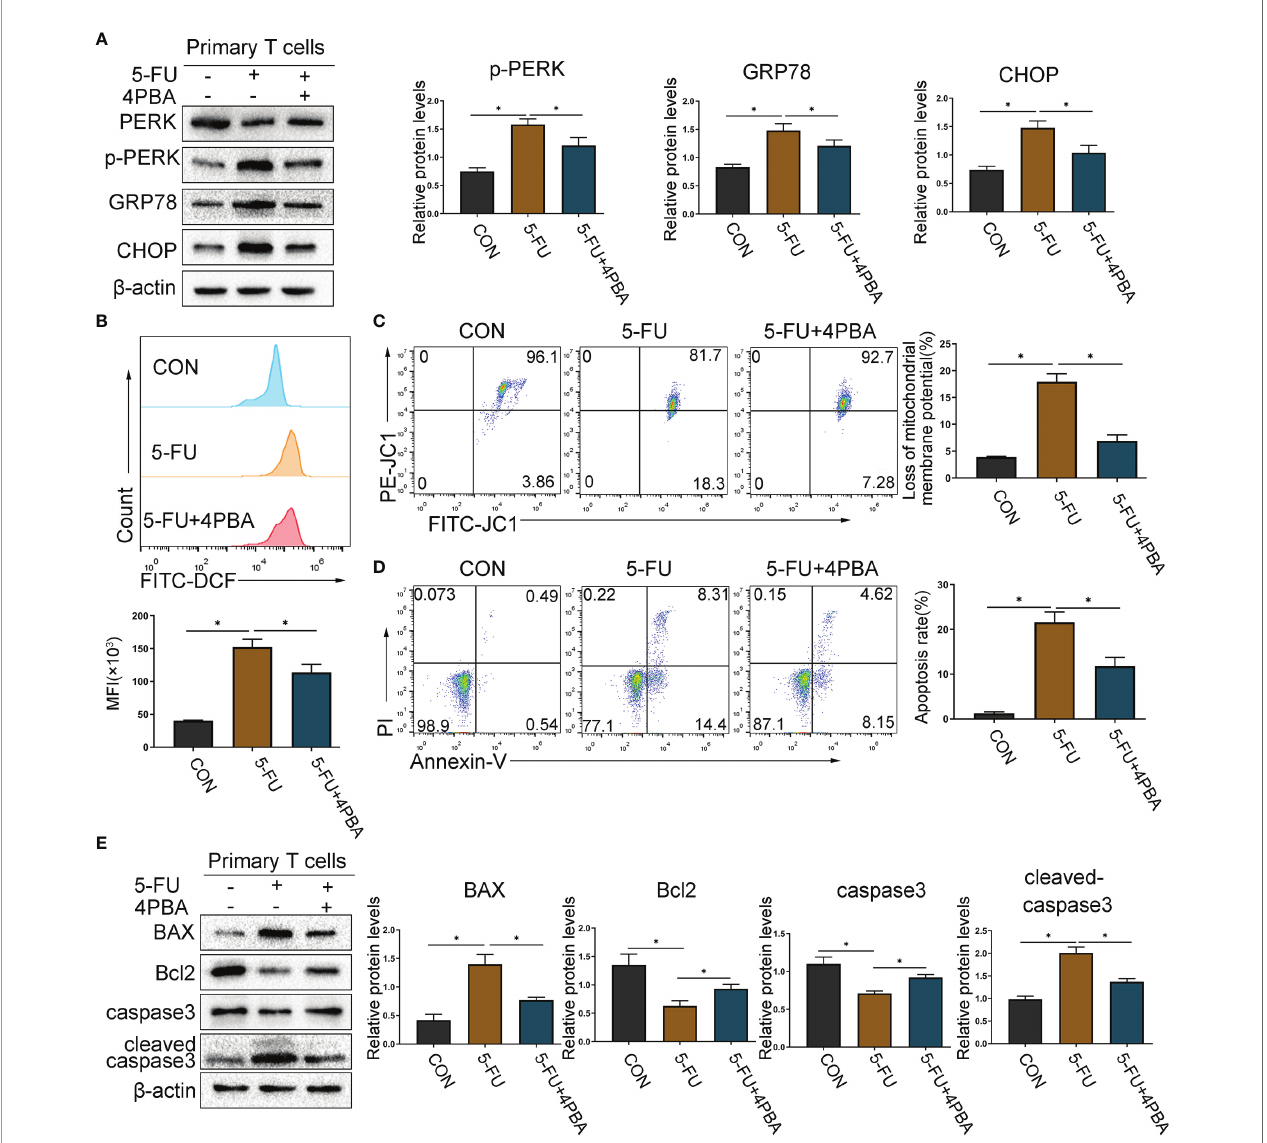
FIGURE 7 | Inhibition of ERS attenuates CAP-induced primary T cells apoptosis. CD3 + T cells were sorted by magnetic beads isolation and in vitro stimulation with anti-CD3/CD28 antibodies. Primary T cells were exposed to 5-FU (0 m M and 10 m M) or 5-FU (10 m M) + 4PBA (1000 m M) for 48 h. (A) ERS-related proteins PERK, p-PERK, GRP78, and CHOP were detected by western blot analysis. (B) The ROS level was detected with fl uorescent probes (DCFH-DA) using fl ow cytometry. (C) The proportion of cells with reduced mitochondrial membrane potential was detected using fl ow cytometry. (D) The apoptosis of T cells was detected by Annexin V and PI staining. (E) The protein levels of apoptosis-related proteins, including caspase3, Bcl2, and BAX, were evaluated using western blot assay. Data are shown as mean ± SD. * P <